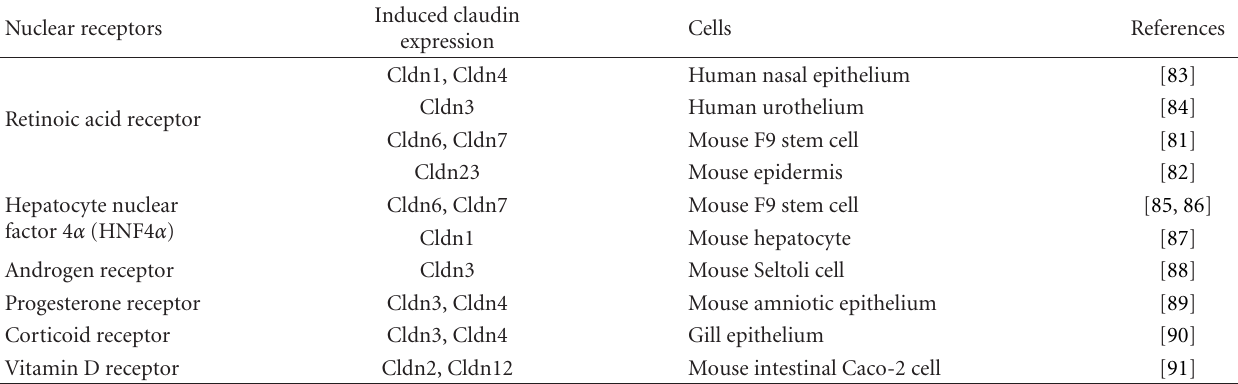
Table 1: Nuclear receptors induce the expression of